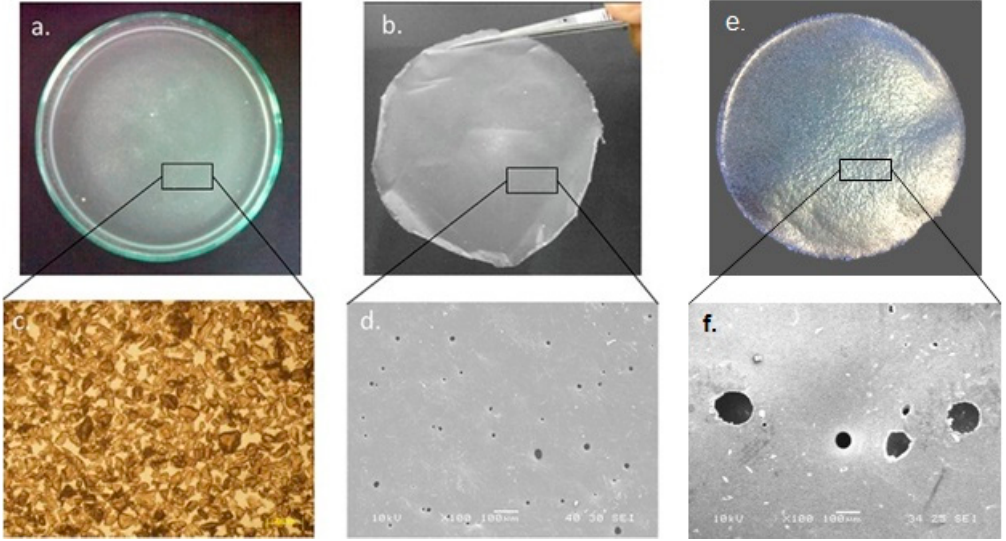
Figure 2. ( a ) Macroscopic of the powder dispersion on the water surface; ( b ) Macroscopic view of membrane made from 100 µm powder; ( c ) Microscopic image of the powder dispersion under a light microscope with ×10 magnification; ( d ) Microscopic image of membrane made from 100 µm powder surface (SEM at ×100); ( e ) Macroscopic image of membrane made from 500 µm powder; and ( f ) Microscopic image of membrane made from 500 µm powder surface (SEM at ×100).